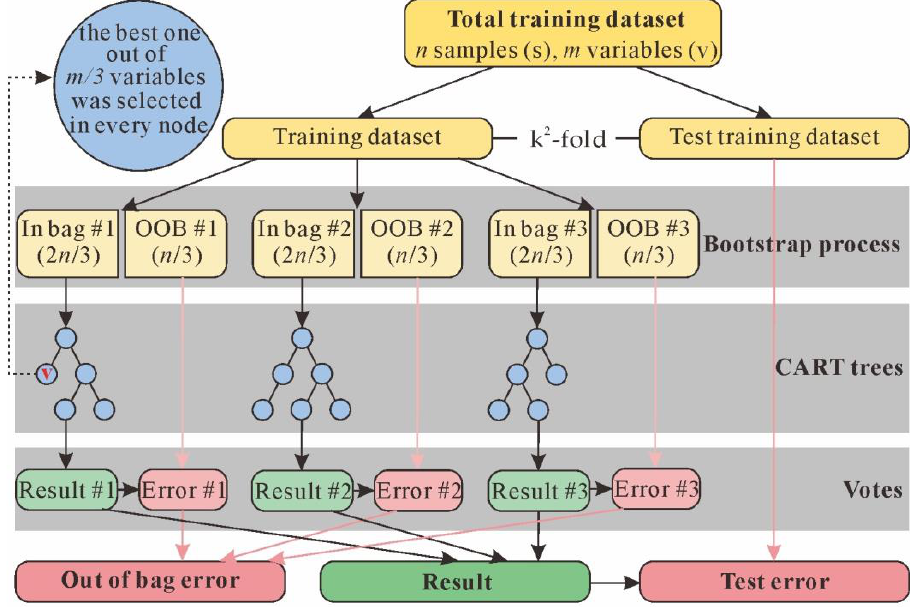
Figure 5. Flowchart of RF algorithm (adapted from [1]). Table 7. Illustration of training and test training datasets of 5 2 -fold cross-validation.